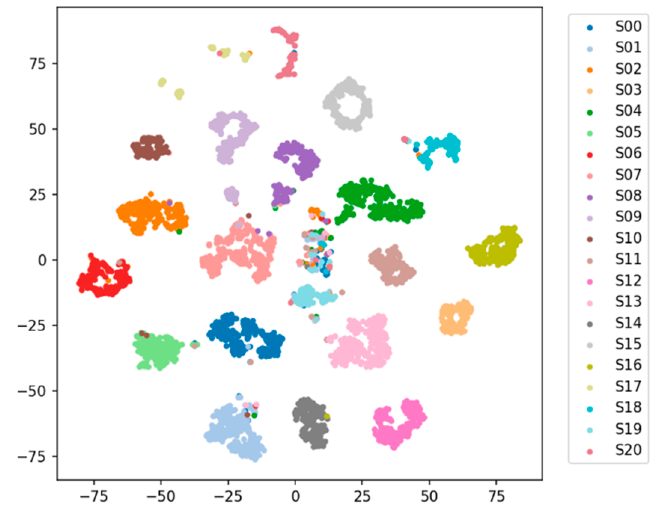
in Figure A2. Each 2D point represents the projected feature embedding of a data segment of ap- proximately 1 s.